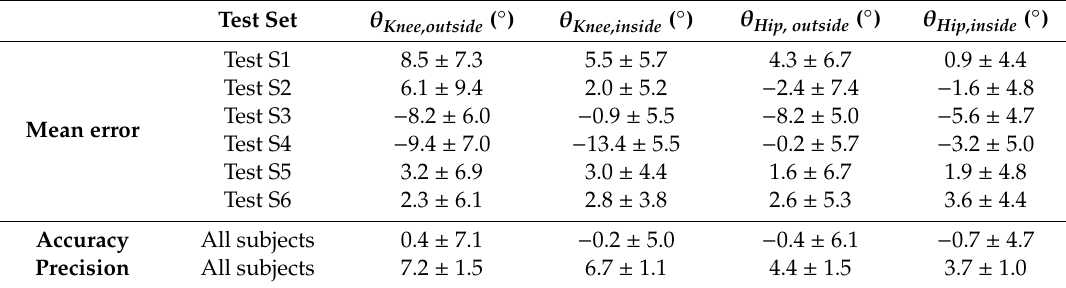
Table 3. Accuracy and precision of knee and hip flexion angles of the turn outside and inside leg based on a monocular 3D reconstruction (averages over the cameras CAM 3 and CAM 5).